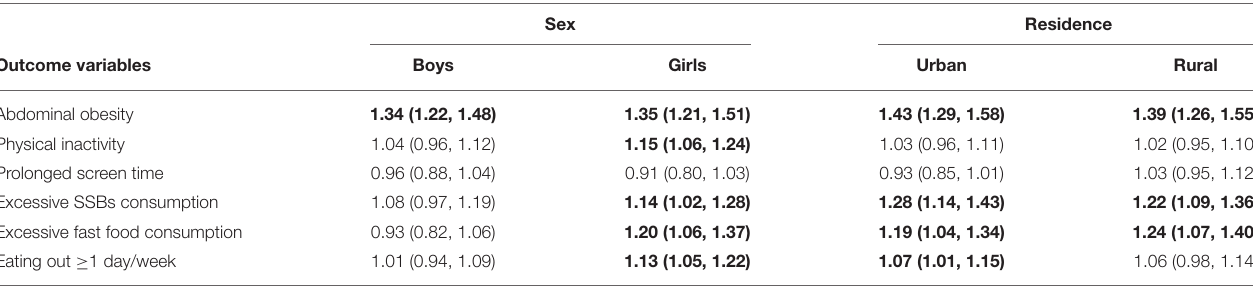
TABLE 3 | The associations between single-child status (single children vs. non-single children) and odds of abdominal obesity and unideal energy-related behaviors by gender and